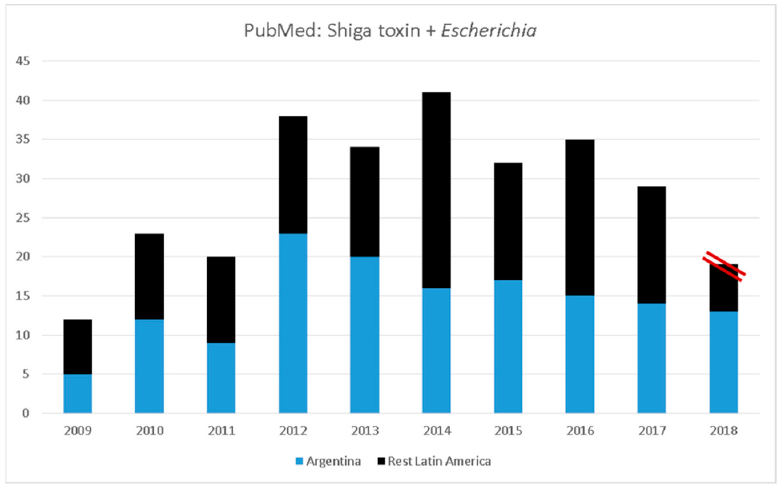
Figure 2. Summary of STEC/EHEC-related peer-reviewed publications by LACER members. A publication summary derived from the PubMed search engine based on numbers returned using the search terms “Shiga toxin” and “ Escherichia ” of the past 9 years, divided by authors from Argentina (light blue) and other Latin American countries (black). Red parallel lines indicated partial number of publications for 2018.